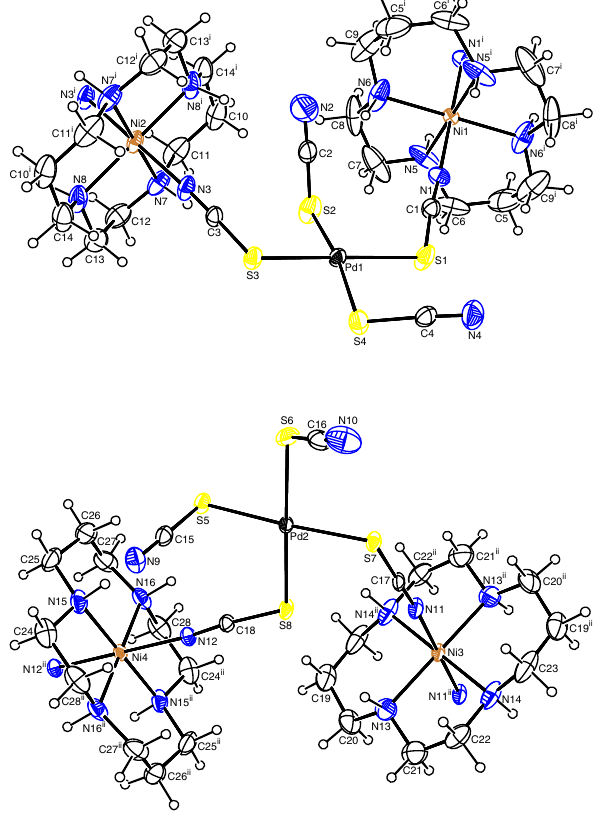
Table  : Data collection and